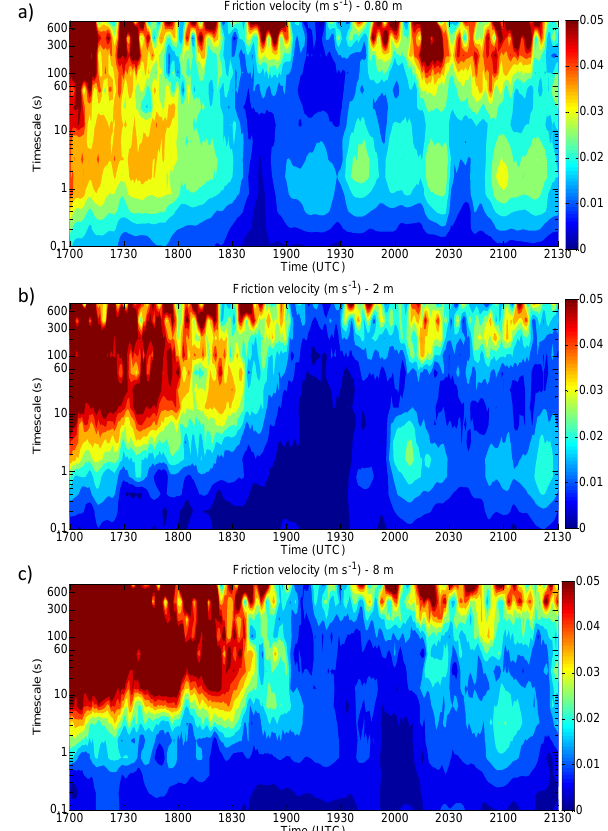
Figure 9. Multi-resolution flux decomposition (MRFD) of the friction velocity (ms − 1 ) at 0.8ma.g.l. (a) , 2ma.g.l. (b) and 8ma.g.l. (c) at the divergence